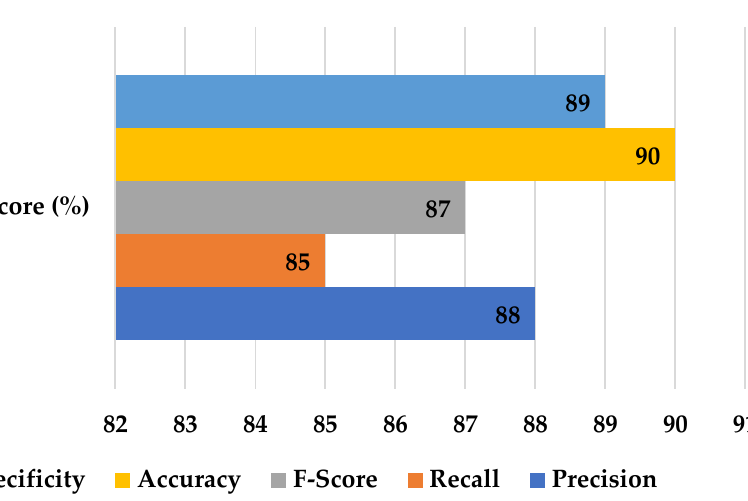
Figure 4. Classification results of the proposed approach.